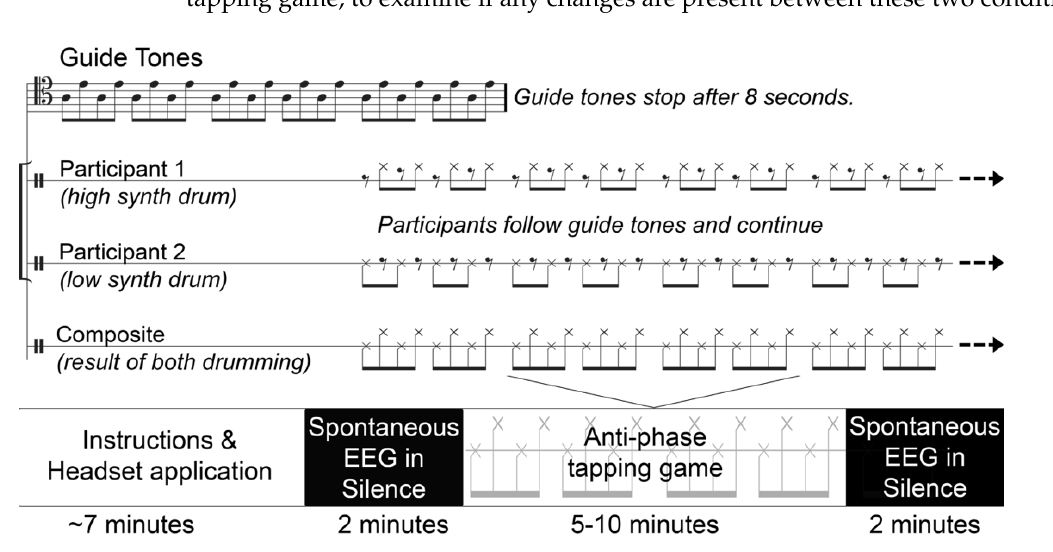
Figure 3. ( Top ) Representation of one instance of the anti-phase tapping game. The sequence above was repeated multiple times at increasing rates (tempi) selected by participants. ( Bottom ) Representation of the entire study procedure each dyad underwent.